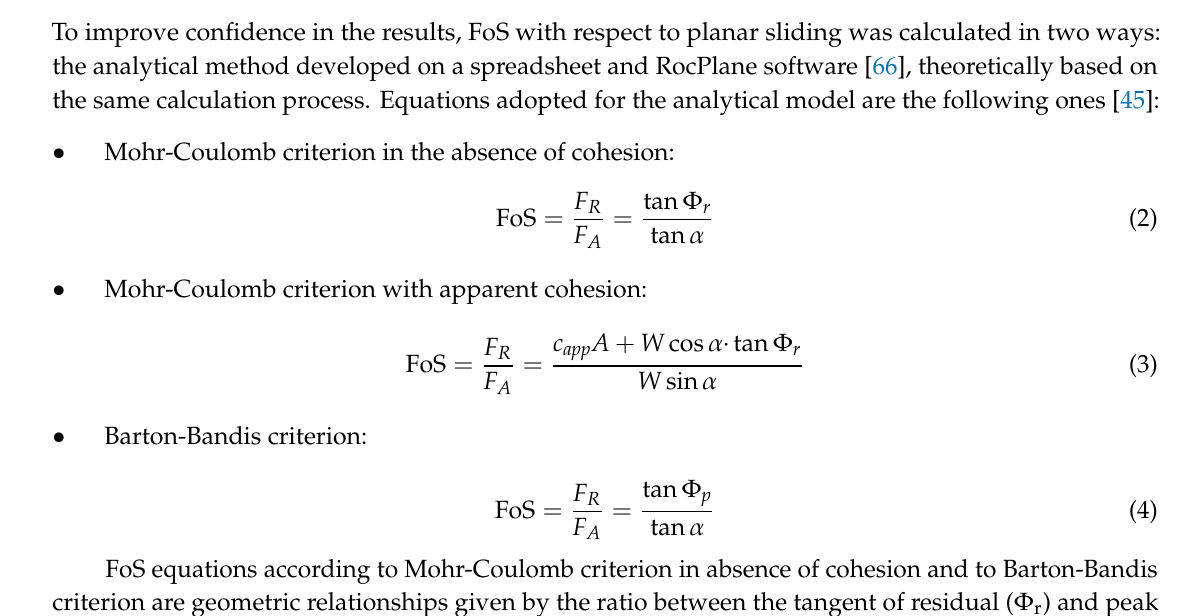
Figure 10. Slope section representing ( a ) a fully persistent joint (persistence equal to 100%), ( b ) an intermittent joint (persistence < 100% due to rock bridges) (from [65]).